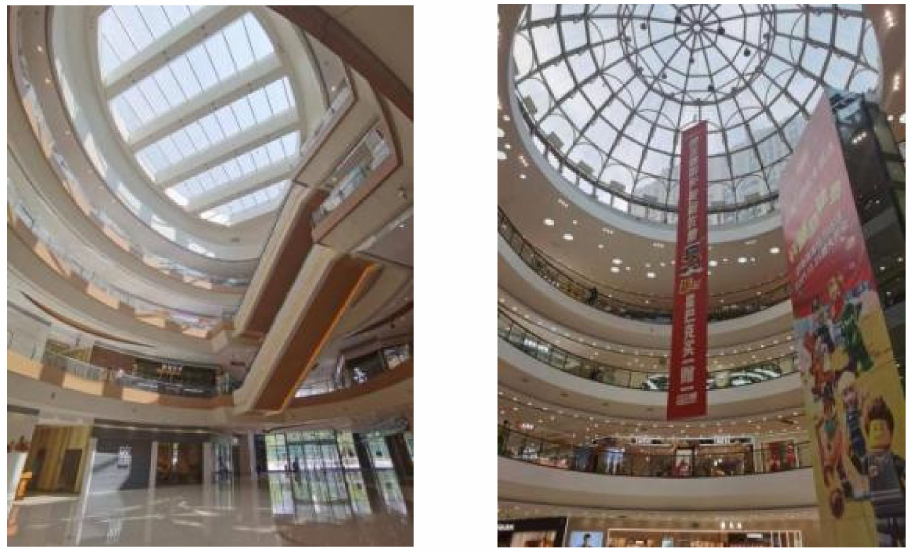
Figure 1. Commercial building atrium photos (Author self